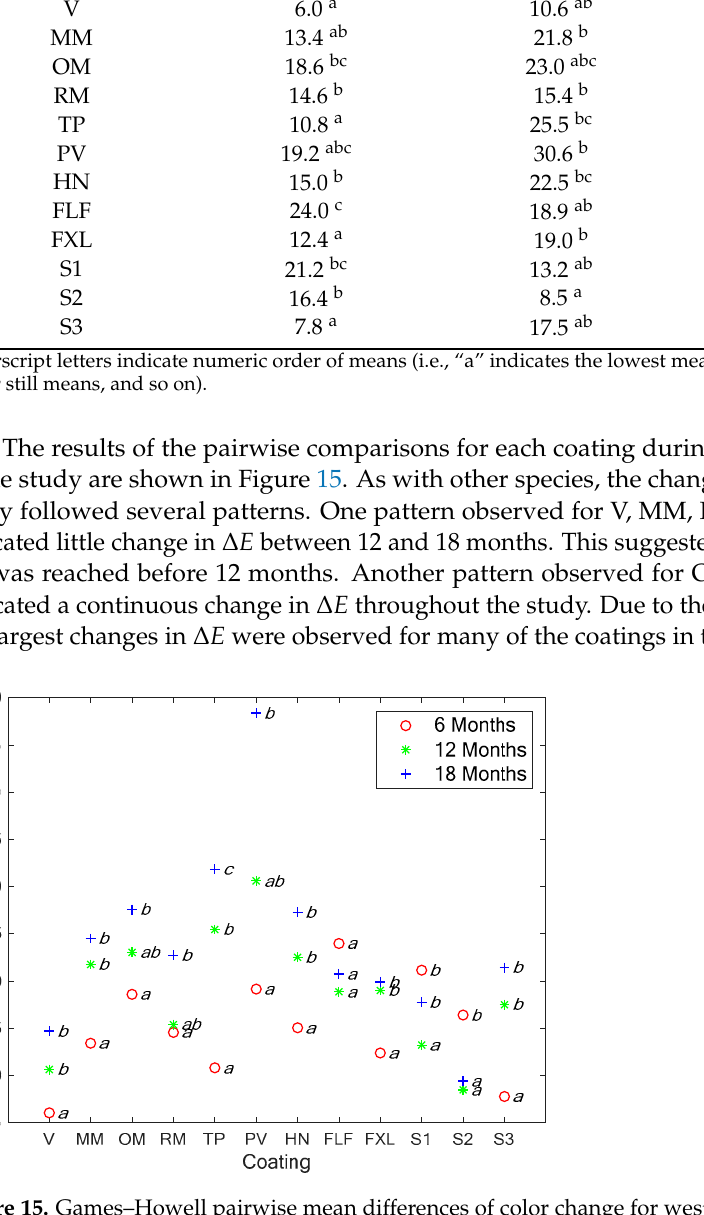
Table 6. Games–Howell pairwise mean differences of color change for western redcedar wood during each interval of the study. Letters in superscripts indicate the treatment groups with means that are not significantly different at the p < 0.05 level.